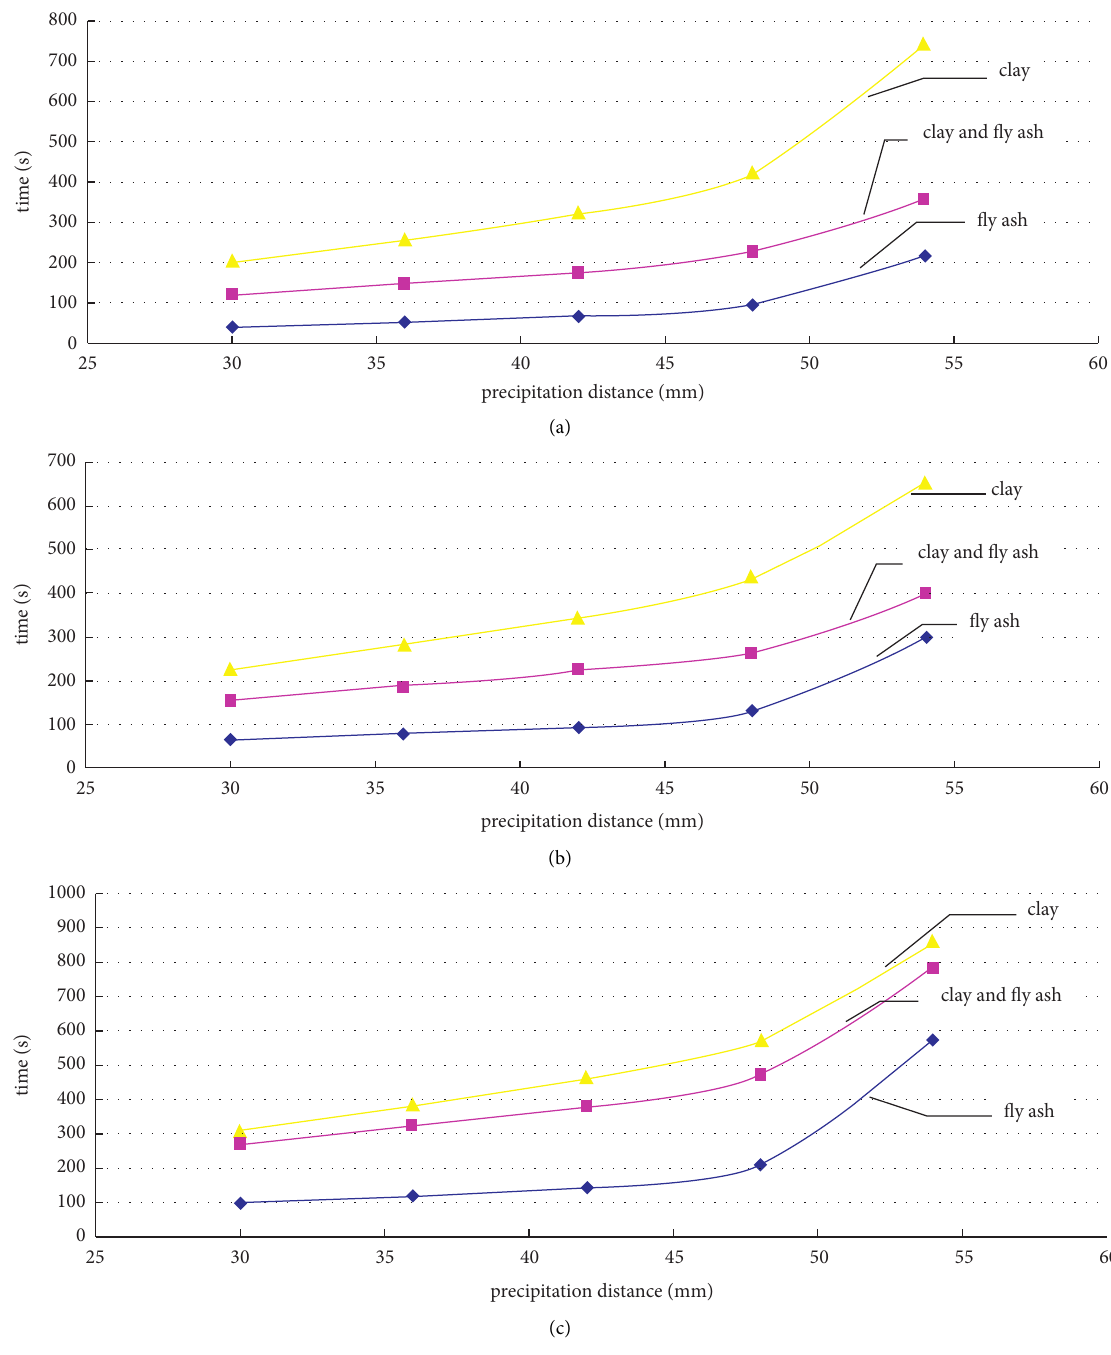
Figure 7: The relationship curve of the precipitation distance and time of different slurries at different temperatures: (a) the relationship between precipitation distance and time for different slurries at 36 ° C, (b) the relationship between precipitation distance and time for different slurries at 16 ° C, and (c) the relationship between precipitation distance and time for different slurries at 0 °